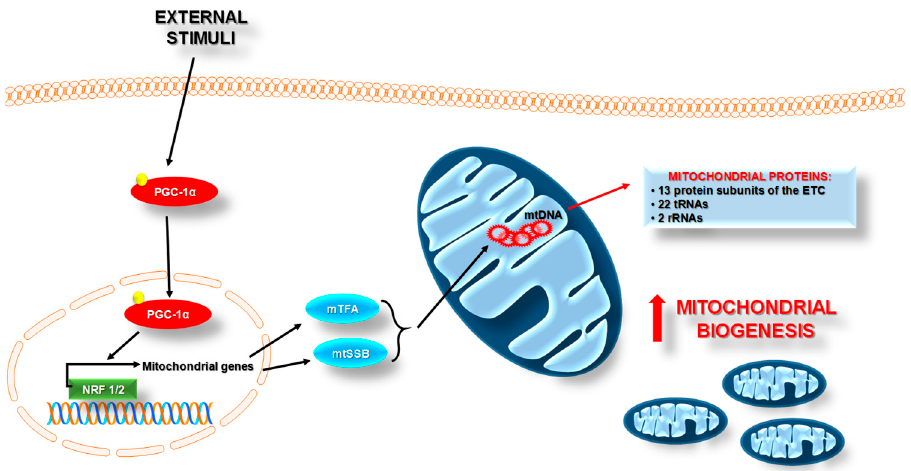
Figure 2. The scheme of mitochondrial biogenesis regulation. Mitochondrial biogenesis is the multistep cellular process by which cells increase the mitochondrial number. This process is activated by numerous different signals during cellular stress or in response to environmental stimuli. In response to external factors, the transcription factors are activated, especially PGC-1 α (peroxisome proliferator-activated receptor-gamma coactivator-1 α ). PGC-1 α is found mainly in the cytosol. Upon activation, it translocates to the nucleus, where it coactivates various energy metabolism-relevant transcription factors—NRF1/NRF2 (nuclear respiratory factors 1 and 2); ERR- α , - β , and - γ (the estrogen-related receptors – α , – β , and – γ ); and NRF2/NFE2L2 (nuclear factor erythroid 2-related factor 2)—which then induce the expression of genes encoding proteins in electron transport chains (ETC), and along with mTFA (the mitochondrial transcription factor A) and mtSSB (the mitochondrial single-stranded DNA-binding protein), regulate the transcription, replication, and synthesis of new mtDNA.